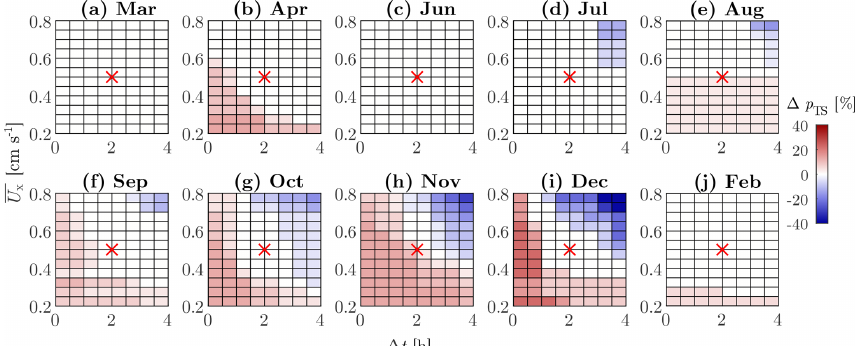
Figure D1. Sensitivity analysis for the criteria used to define cross-shore flows. The effects of modifying the depth-averaged cross-shore velocity U x and the averaging duration (cid:49)t are shown as changes in the percentage of occurrence of TSs ( p TS ) for each month. (cid:49)p TS is the percentage difference with respect to the occurrence shown in Fig. 5, obtained with U x = 0 . 5cms − 1 and (cid:49)t = 2h (reference point shown by the red cross).